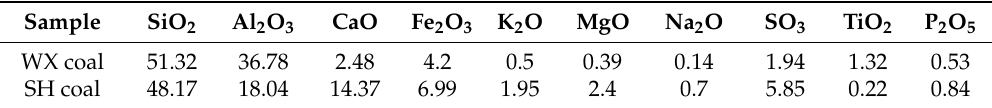
Table 2. Chemical compositions of the coal ash samples